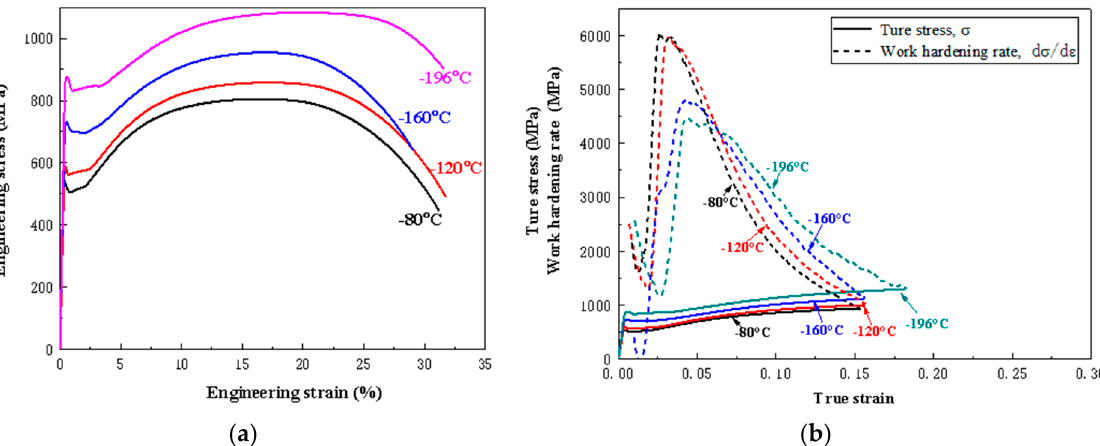
Figure 3. ( a ) Engineering stress–strain curves and ( b ) true stress–strain curves and work hardening rate of the studied steel at low temperatures.